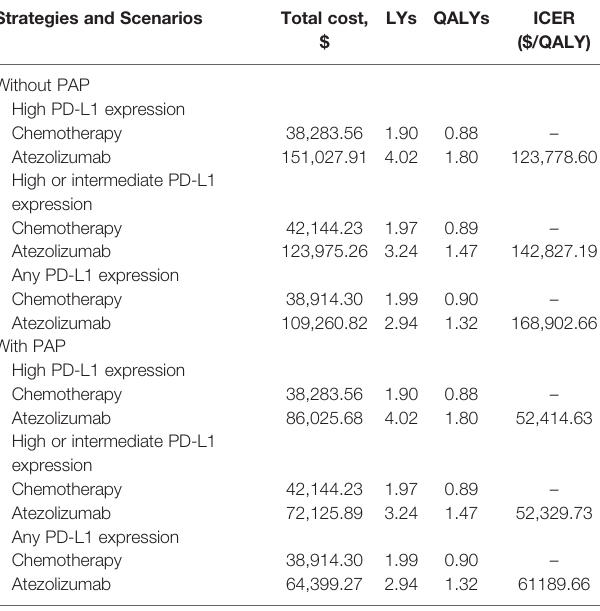
TABLE 2 | Base-case